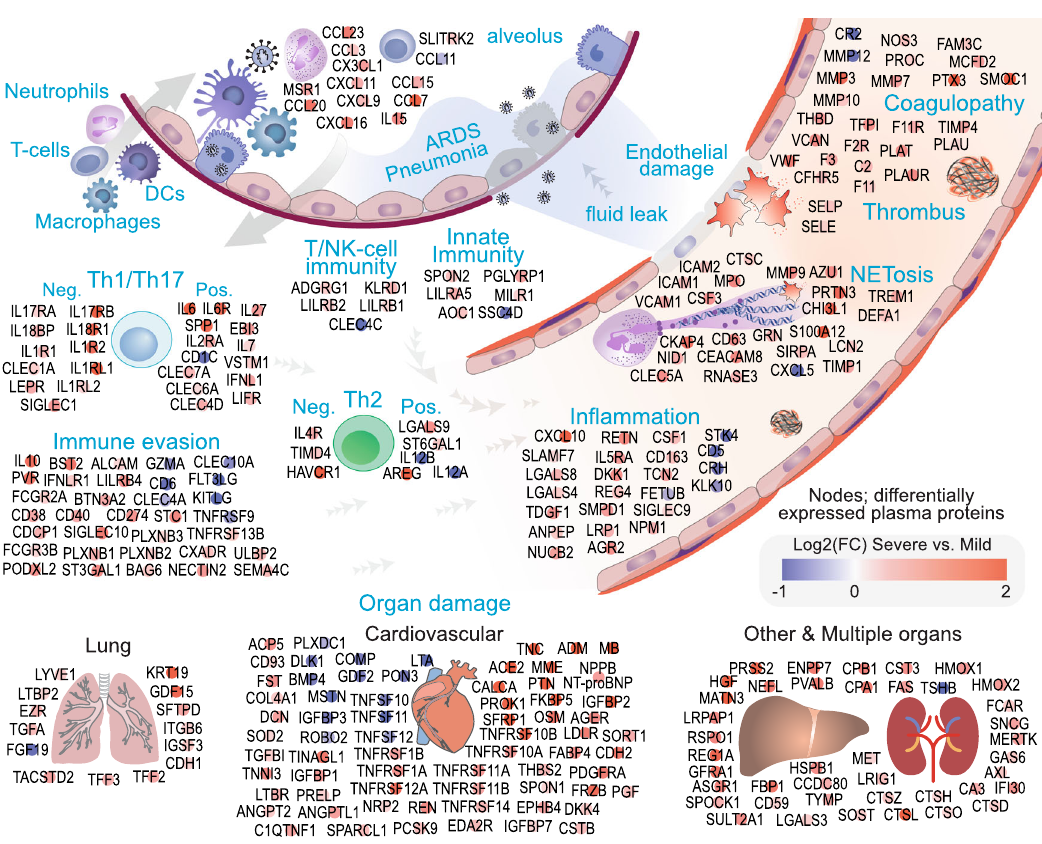
Fig. 2 Functional analysis of deregulated plasma proteins in severe versus mild COVID-19 disease. Differentially expressed proteins (DEPs) in patients with severe complications compared to mild-moderate disease were subjected to network analysis using the STRING-db (Supplementary Fig. 3) and annotation for their function as circulating proteins (Supplementary Data 3 and Supplementary Notes). Of the 375 DEPs (1.25-fold change in severe vs. mild cases), 288 (77%) DEPs shown in the Figure could be allocated to 11 functional groups considering their potential function as circulating proteins; chemotaxis, coagulopathy/ fi brinolysis, immune evasion, innate immunity, T- or NK-cell immunity, T-/Th-cells dysfunction, in fl ammation, neutrophils/ neutrophil extracellular traps (NETosis), and organ damage (lung, cardiovascular or other and multiple organs). The remaining 87 DEPs were either known to exist in circulation with unclear function or with known function but with no literature supporting their secretion or release into the blood (see Supplementary Data 3 and Supplementary Notes). The color intensities (red: upregulated, blue: downregulated; legend) depict the log2 fold-change between severe and mild-moderate cases. DEPs are classi fi ed as agonists (pos.) or antagonist (neg.) for the Th1/Th17 and Th2 immune responses. Network interactions between the 278 DEPs and their correlation with clinical blood test are shown in Supplementary Fig. and immunomodulatory drugs (e.g., anakinra, methotrexate, Data 4). Brie fl y, the FDA-approved drugs list included anti-viral tocilizumab, atezolizumab, and nivolumab). drugs (e.g., ribavirin and ritonavir), anticoagulant and thrombo- lytic drugs (e.g., tenecteplase), corticosteroids and glucocorticoids which were upregulated by greater than or equal to 2-fold in (e.g., dexamethasone, methylprednisolone and prednisone), non- severe versus mild-moderate groups (Fig. 4a), compared to the 38 steroidal anti-in fl ammatory (e.g., aspirin and indomethacin), drugs that target single proteins which were upregulated by 1.5 to nonsteroidal antiandrogen (e.g., fl utamide), immunosuppressive 2-fold in severe COVID-19 (Supplementary Fig. 4). A notable feature of the PDI networks is the large interactions between the